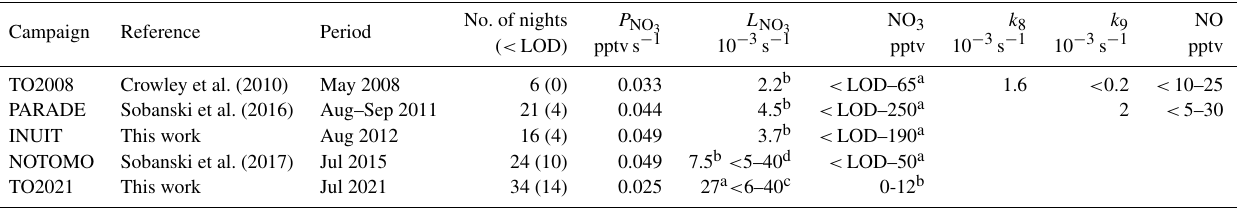
Figure 10. (a) NO 3 production (left) and loss rates (right) during TO2021. (b) Steady-state NO 3 mixing ratios. Ticks represent 00:00UTC. Grey shaded areas denote nighttime. Table 1. Nighttime NO 3 and NO mixing ratios, median NO 3 production rates, and median nighttime NO 3 loss rates at the top of the Kleiner